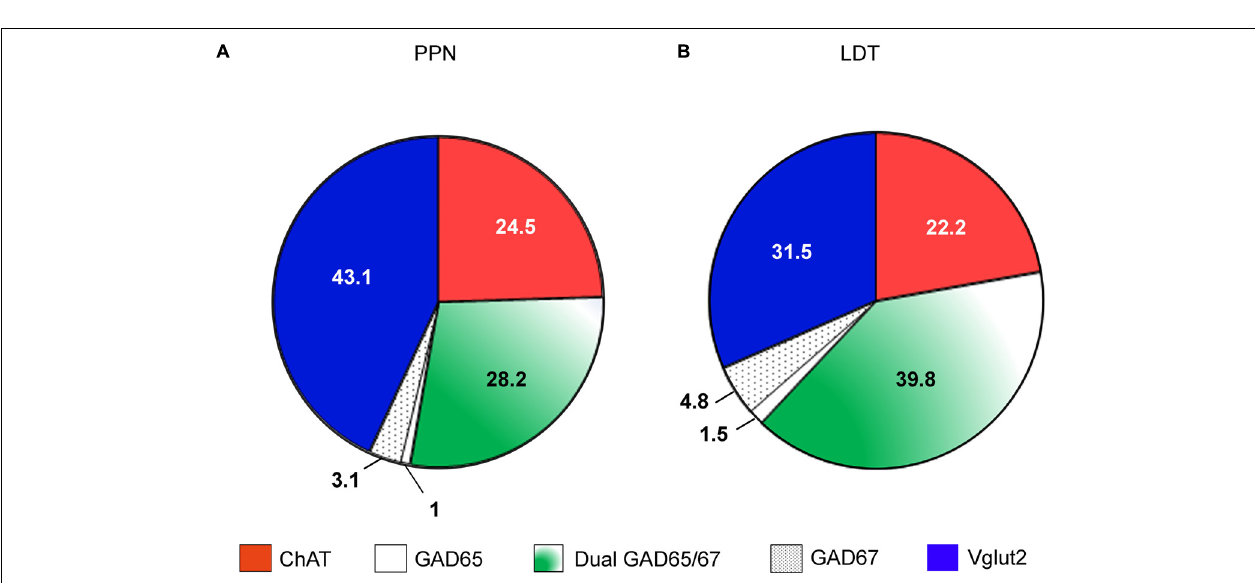
FIGURE 8 | Virtual lack of colocalization of GAD67 and Vglut2 in PPN and LDT. (A–C) Single plane confocal images from the PPN showing GAD67 ( A , red channel), Vglut2 ( B , blue channel), and the triple labeled merged image (C) . (A’–C’) Confocal images of immunofluorescence labeling in LDT. (C–C’) Merged images of single planes showing the lack of colocalization of GAD67 (red) and Vglut2 mRNAs (blue). ChAT-positive neurons (green) helped to localize the anatomical boundaries of both PPN and LDT. Scale bar: 20 µ m.